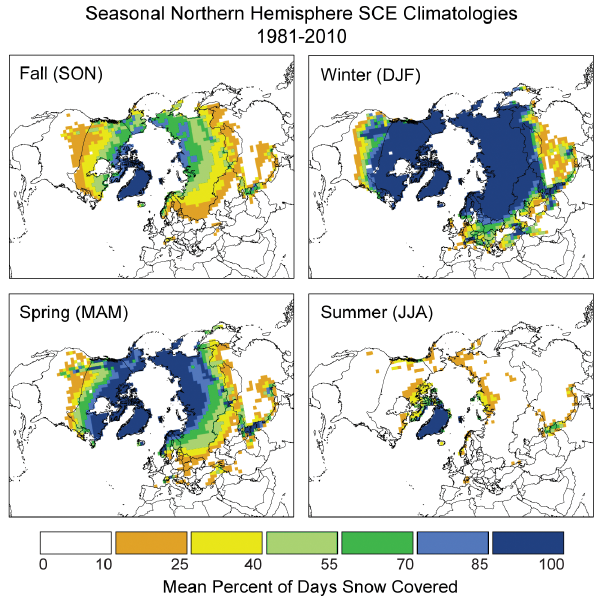
Figure 2. Mean spatial distribution of seasonal SCE over North- ern Hemisphere lands. Each season is calculated using 3-month means. These maps illustrate seasonal variability, with maximum mean SCE occurring in winter. The data period used to calculate means spans the period from January 1981 to December 2010.